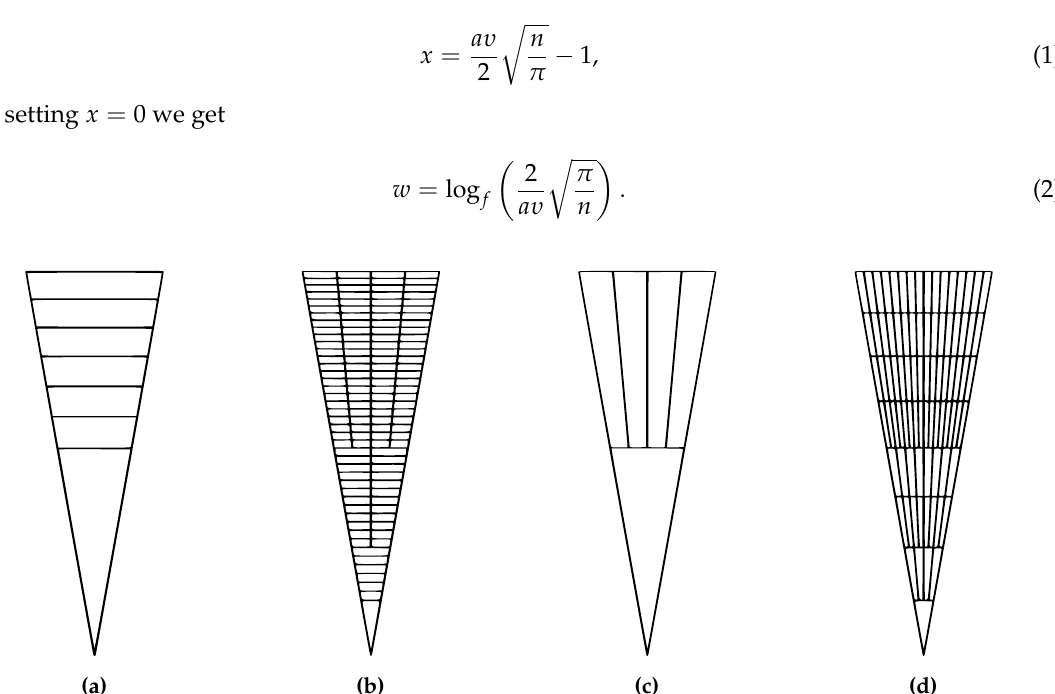
Figure 8. A demonstration of how refinement can be modified to affect the aspect ratio of cells. All figures show a starting pyramid cell from a grid with 200 cells in its initial discretization. Central layer with five extra radial splits ( a = 3 to get x = 5) at ( a ) one level of refinement and ( b ) three levels. Central layer with two applications of the surface refinement scheme ( a = 1/8 to get w = 2) at ( c ) one level of refinement and ( d ) three